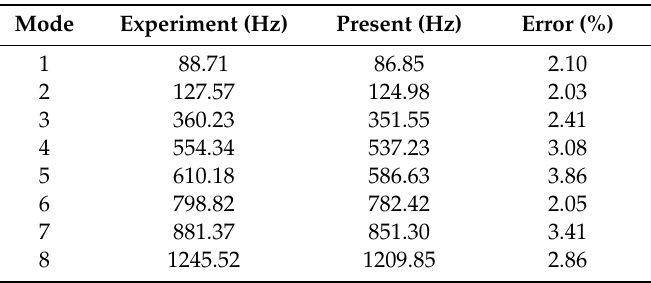
Table 6. Natural frequency of the laminate plate.